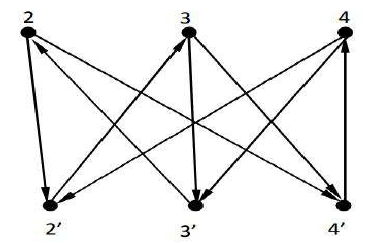
Figure 6. The blackened vertices 2 (cid:48) ,3 (cid:48) ,4 (cid:48)